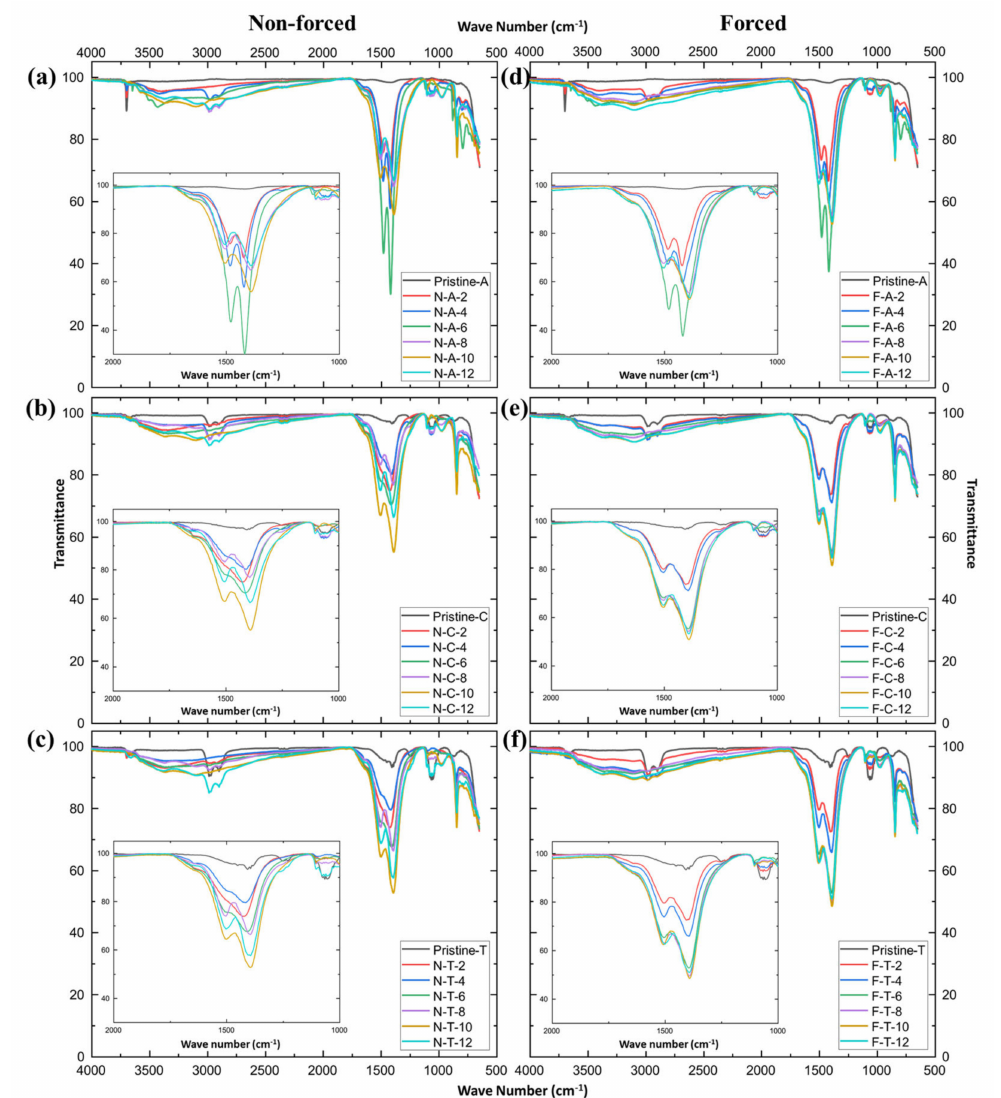
Figure 3. FT-IR spectra results of the pristine MgO nanoparticles and the products after non-forced wet carbonations of ( a ) A-MgO, ( b ) C-MgO and ( c ) T-MgO as well as forced wet carbonations of ( d ) A-MgO, ( e ) C-MgO and ( f )